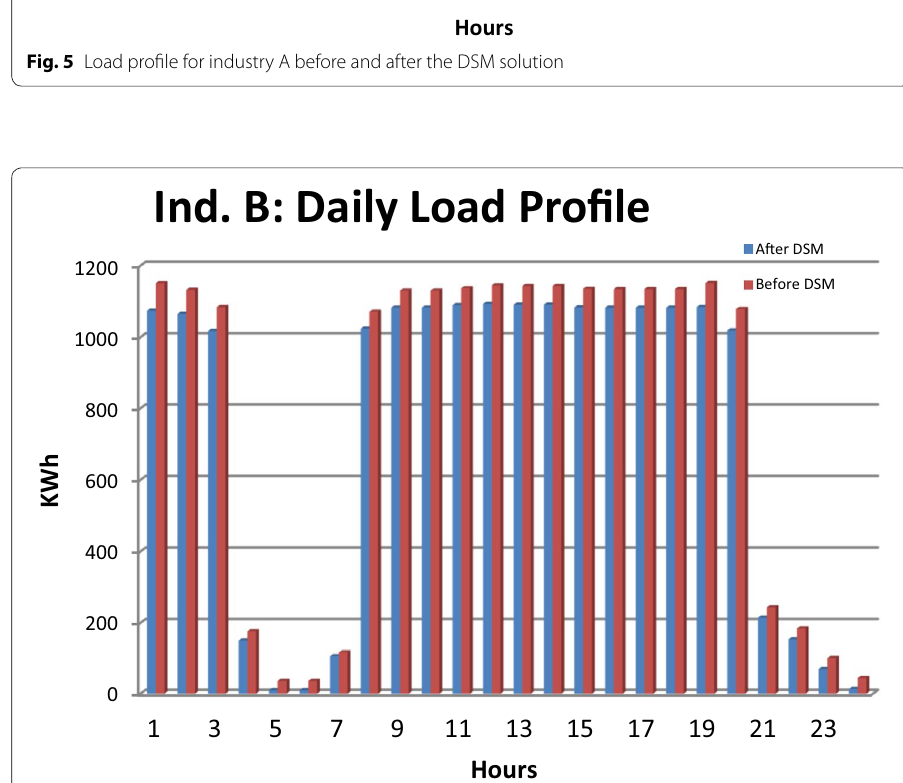
Fig. 6 Load profile for industry B before and after the DSM